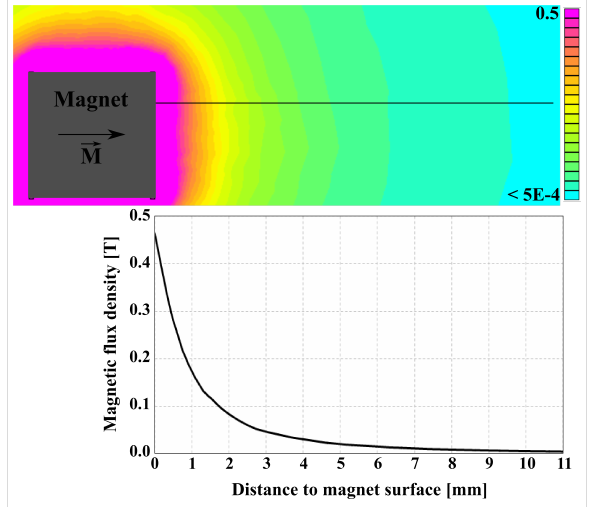
Figure 5: Simulated magnetic field of the permanent magnet. The field dependence on the distance to the surface of the magnet is calculated for the black line, corresponding to the measurement